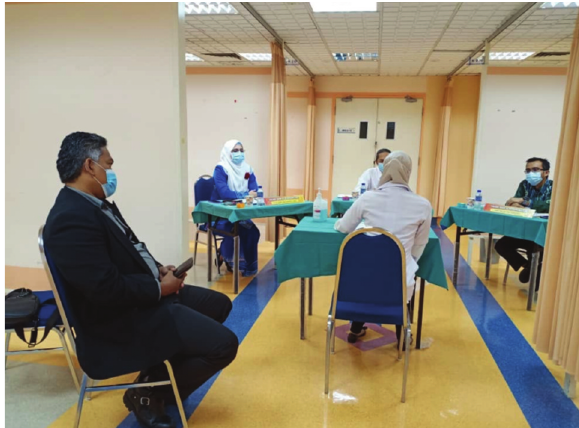
Setting up for the theory paper. Fig. 1: